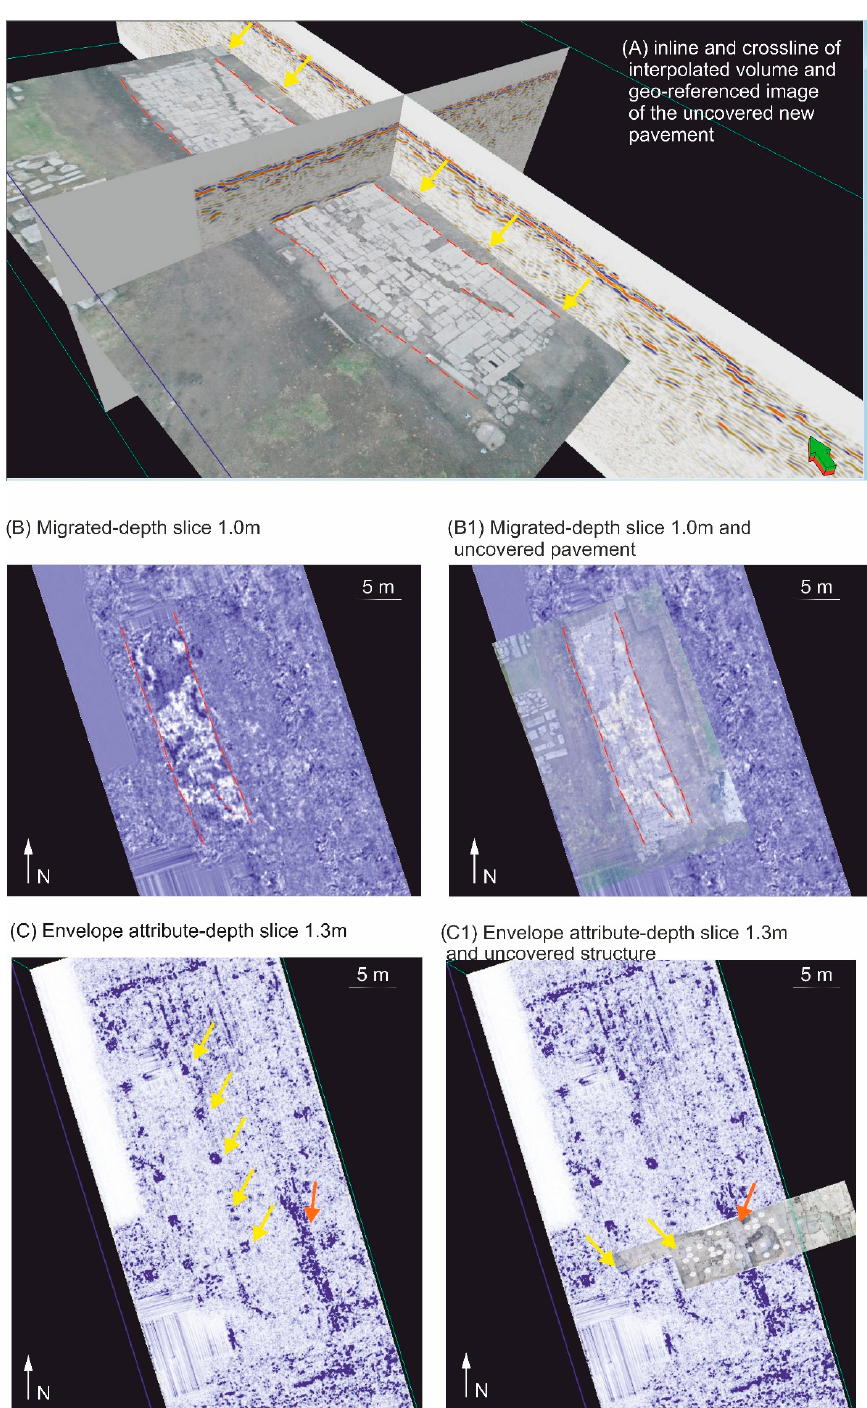
Figure 9. ( A ) Exemplary inline and crossline of a portion of the 3-D GPR volume (location in Figure 2) crossing, respectively, the stone floor of the new excavated square and the equally-spaced features around it (indicated by the yellow arrows); ( B , B1 ) time-migrated slice where the edges of the new square are clearly depicted and the same picture with the photograph of the excavation superimposed, respectively; ( C , C1 ) Envelope attribute calculated on a time-migrated slice and the same picture with the photograph of the excavation superimposed. The yellow arrows indicate some of the equally spaced elements while the red arrow indicates the foundation of a